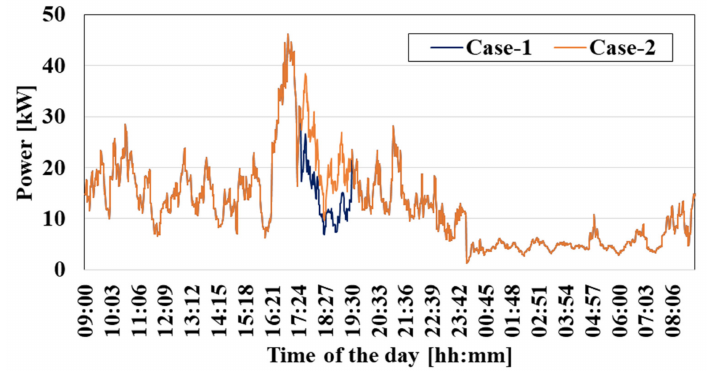
Figure 7. Total power consumption of dwellings in Case-1 and